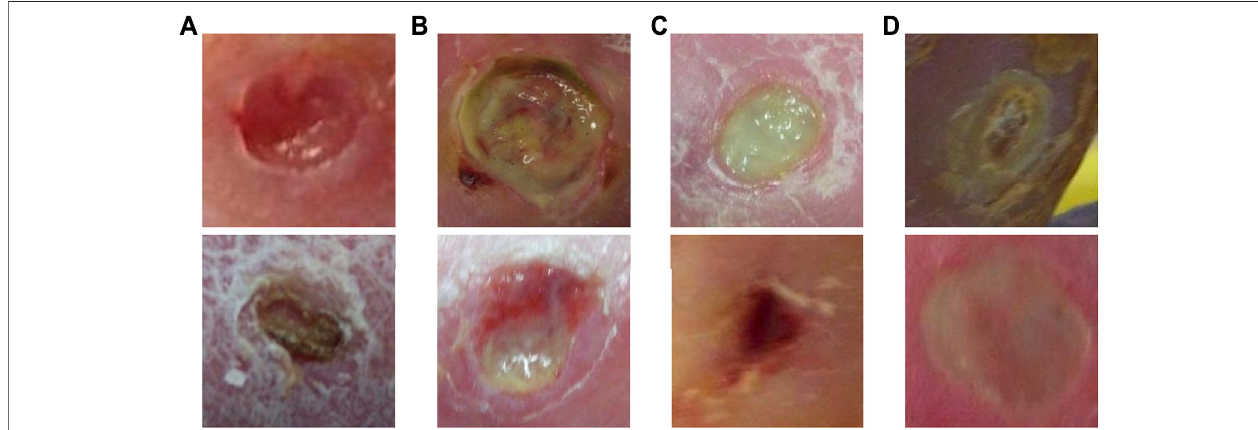
FIGURE 7 | Examples of classi fi cation results of the proposed method on the infection dataset. (A) true negative cases, (B) true positive cases, (C) false negative cases and (D) false positive cases.